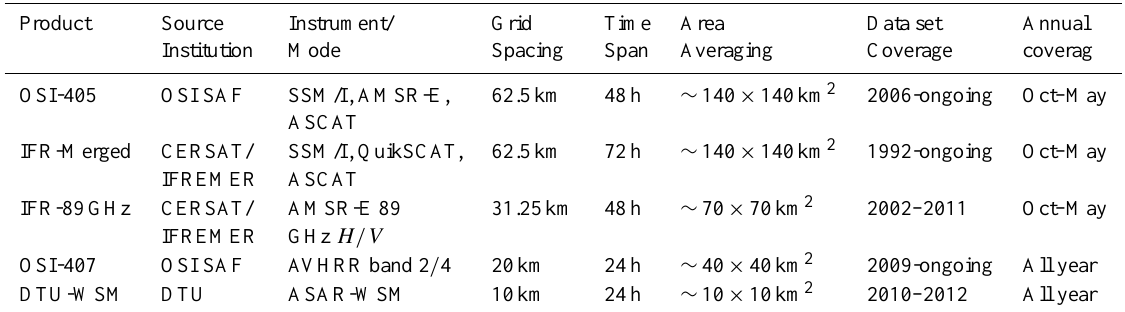
Table 2. Main characteristics of the ice drift data sets available from the Damocles project. Grid Spacing: spacing between ice motion vectors; Time Span: duration of the observed motion; Area Averaging: extent of the area of sea ice that is monitored by each motion vector; Data set